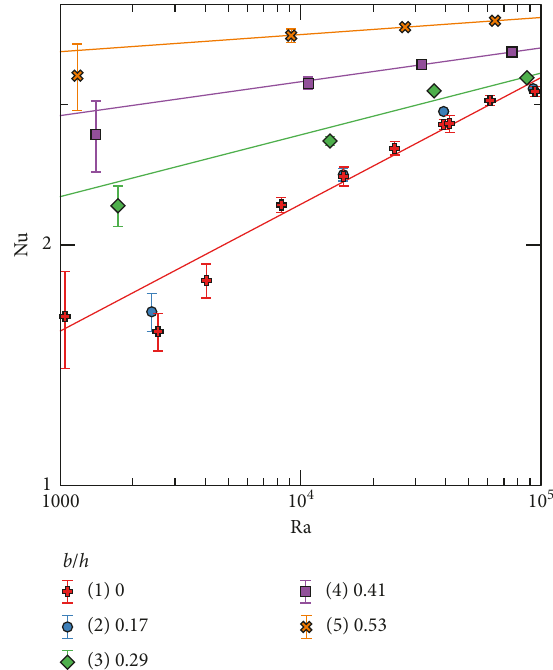
Figure 5: The dependence of Nu on the convective parameter Ra. The experimental series correspond to the following ranges of ω